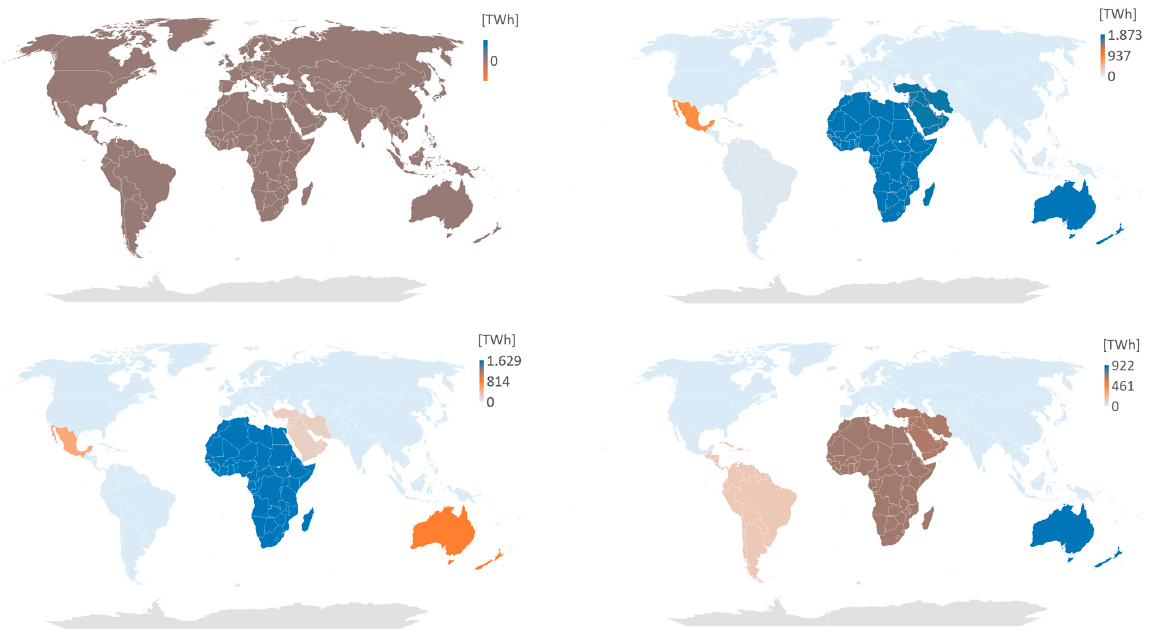
Figure 10. Synfuel export along all scenarios in 2100. BAU is top left, 1_5D is top right, SoS1 is bottom left and SoS2 is bottom right.